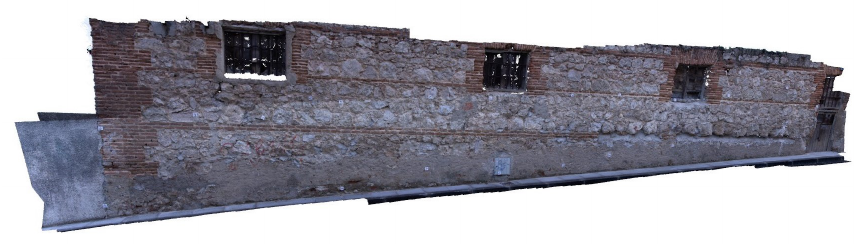
Figure 19. Voxelization with a voxel size of 0.5 cm.